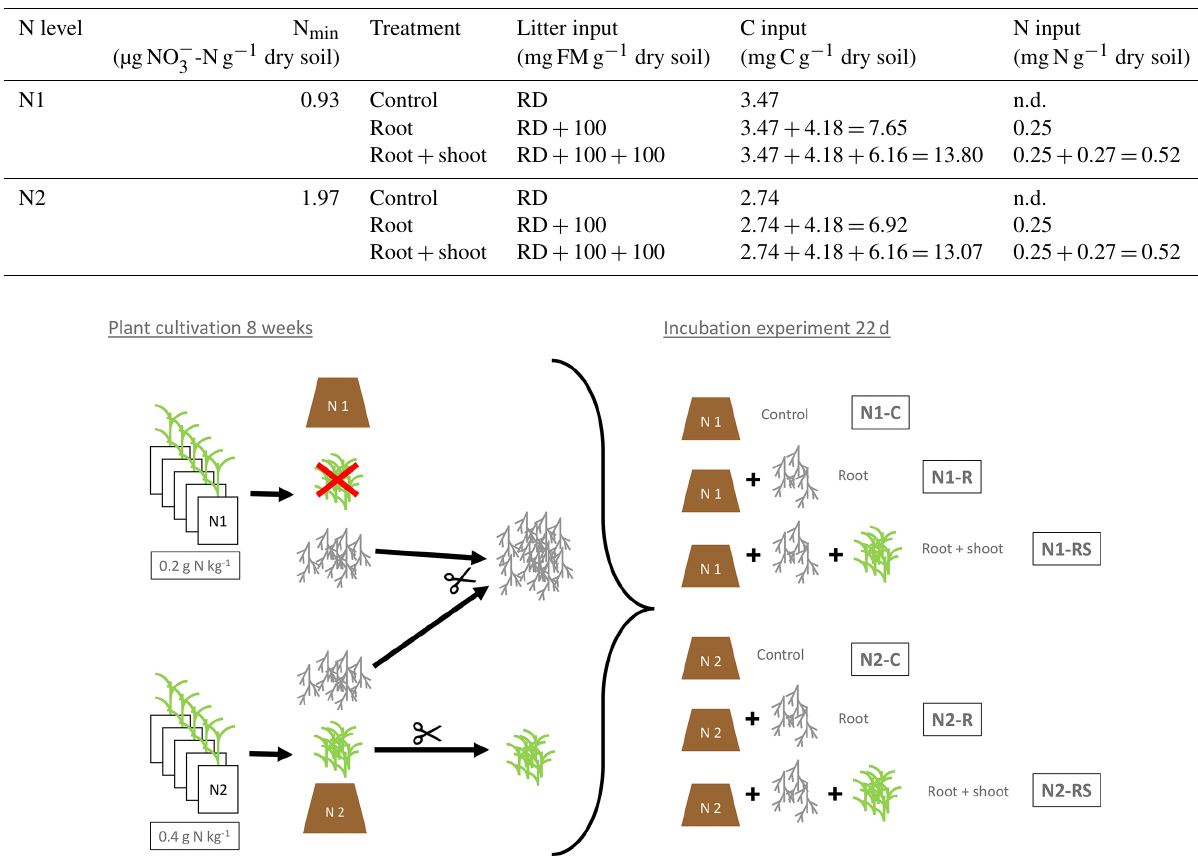
Figure 1. Preparation and experimental setup of the incubation experiment. N1 (0.2gNkg − 1 ) and N2 (2 × 0 . 2gNkg − 1 ) referring to the N levels during plant growth. Control soil (N1-C and N2-C) without addition of plant litter. Root treatment with addition of 100g of fresh root biomass per kilogram of dry soil (N1-R and N2-R) and root + shoot treatment with addition of 100g of root and 100g of shoot biomass per kilogram of dry soil (N1-RS,